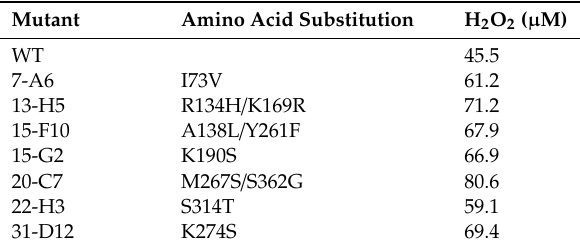
1 The reaction mixture (500 µ L) in a 96-well plate contained around 100 µ L cell lysate, 100 mM methyl glycolate and 50 mM Tris-HCl (pH 8.0). The reaction was carried out at 37 ◦ C and 200 rpm for 8